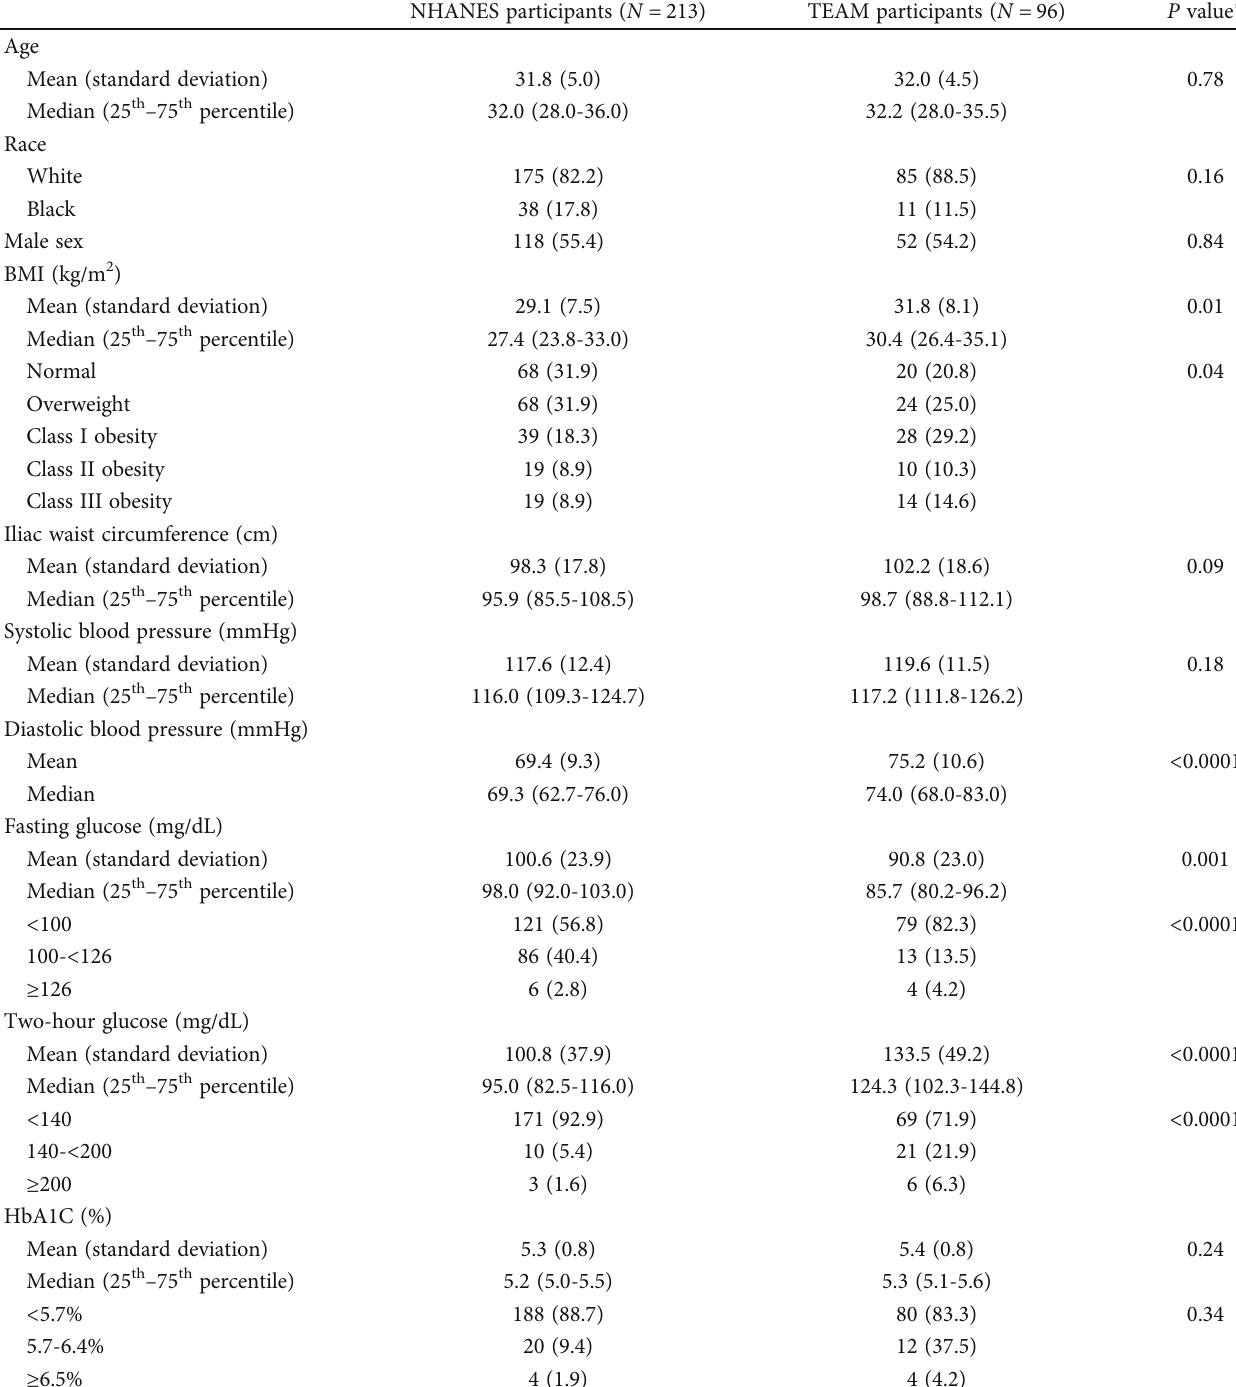
Table 2: Demographic and glycemic measures comparing TEAM participants to NHANES participants matched on age, race, and